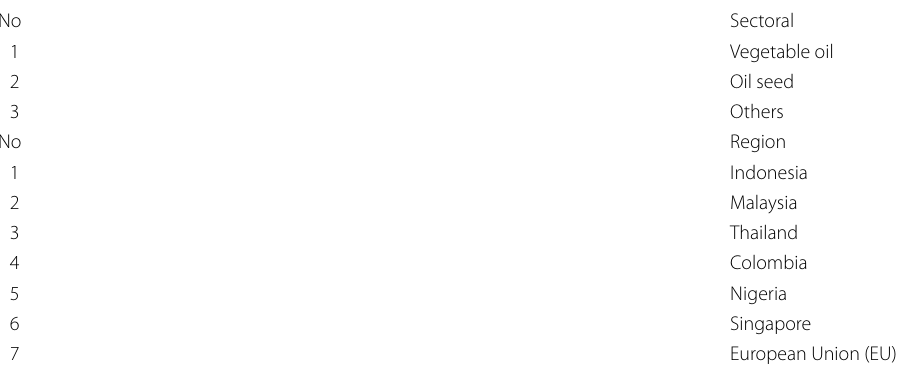
Table 1 Summary of sectoral and regional